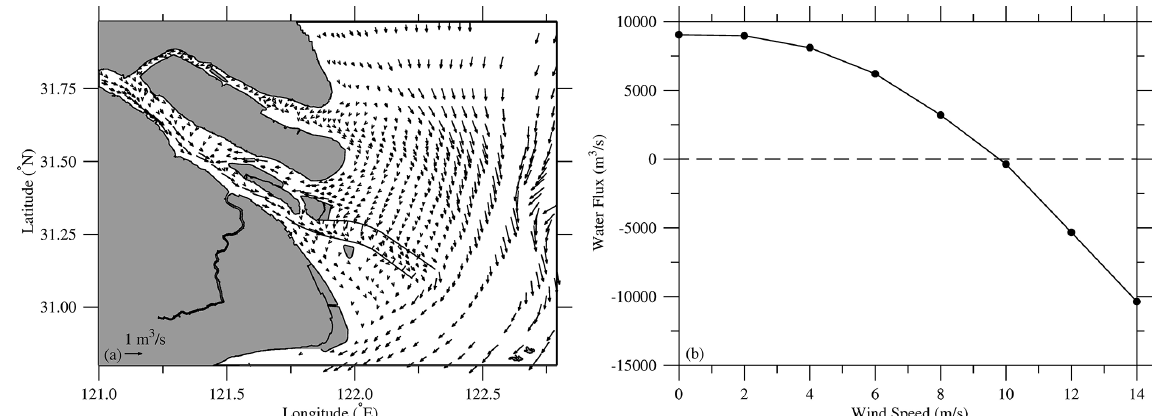
Figure 14. Distribution of a purely wind-driven current, time averaged from 10 to 13 February 2014, modeled under the real wind (a) . Relationship between water flux across sec1 in the northern channel and northerly wind speed (b) . Except for the wind, the other dynamic factors in the numerical experiments are the same as in experiment 2.